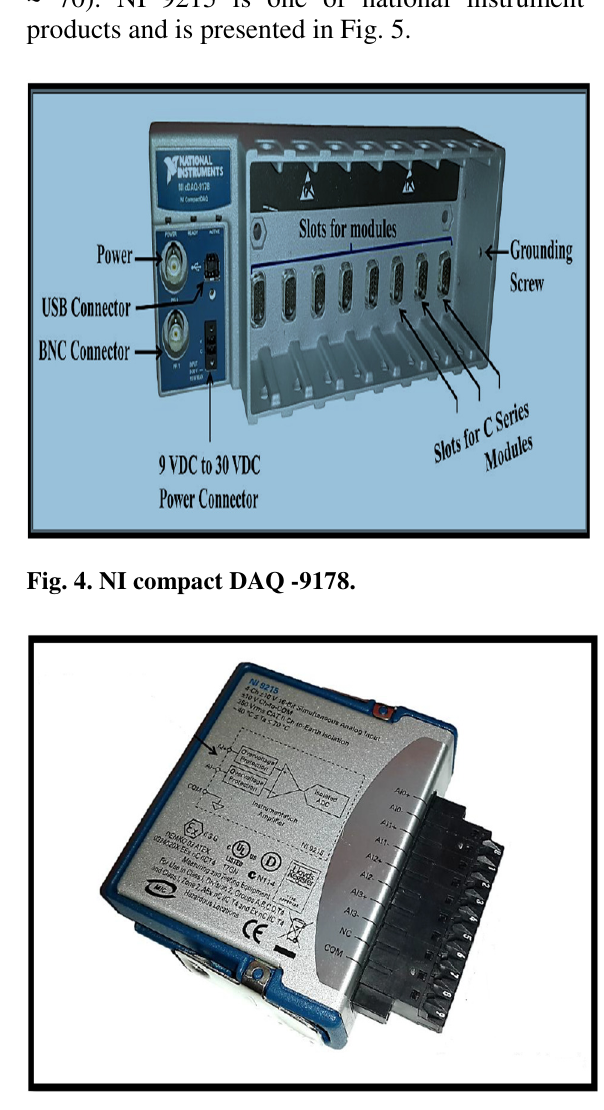
Fig. 5. NI 9215- Analog input voltage.